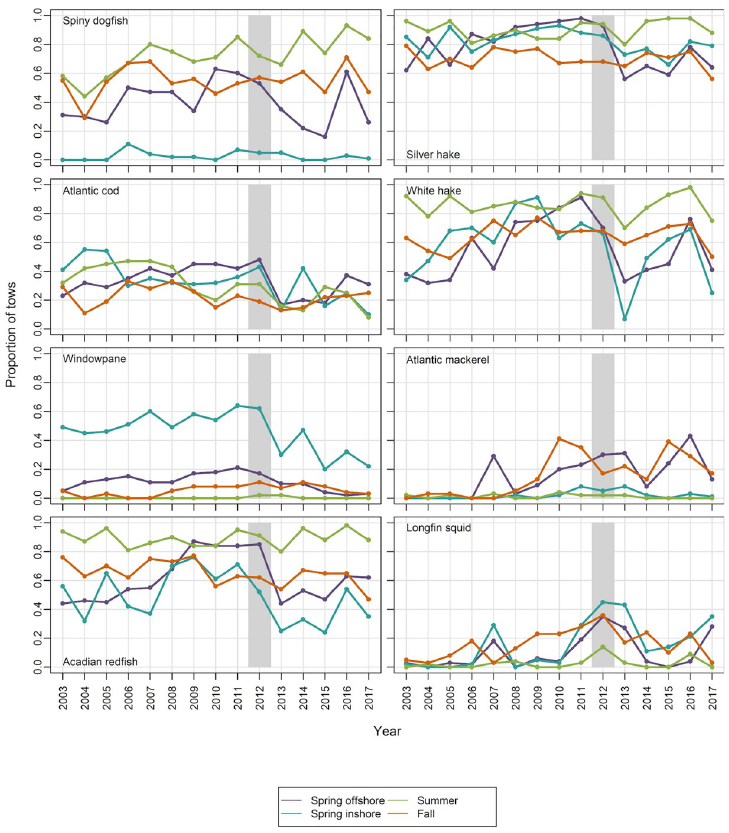
Fig 9. Local index of collocation (proportion of tows catching both predator and northern shrimp). Shaded bar highlights 2012, when the shrimp decline became apparent.